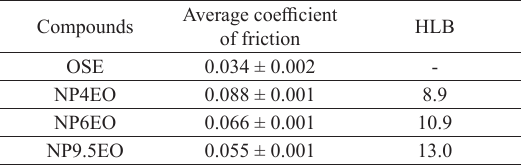
Figure 6. Coefficient of friction behavior for individual surfactants and pure ESO. Table 7. Coefficient of friction obtained with the OSE and nonionic